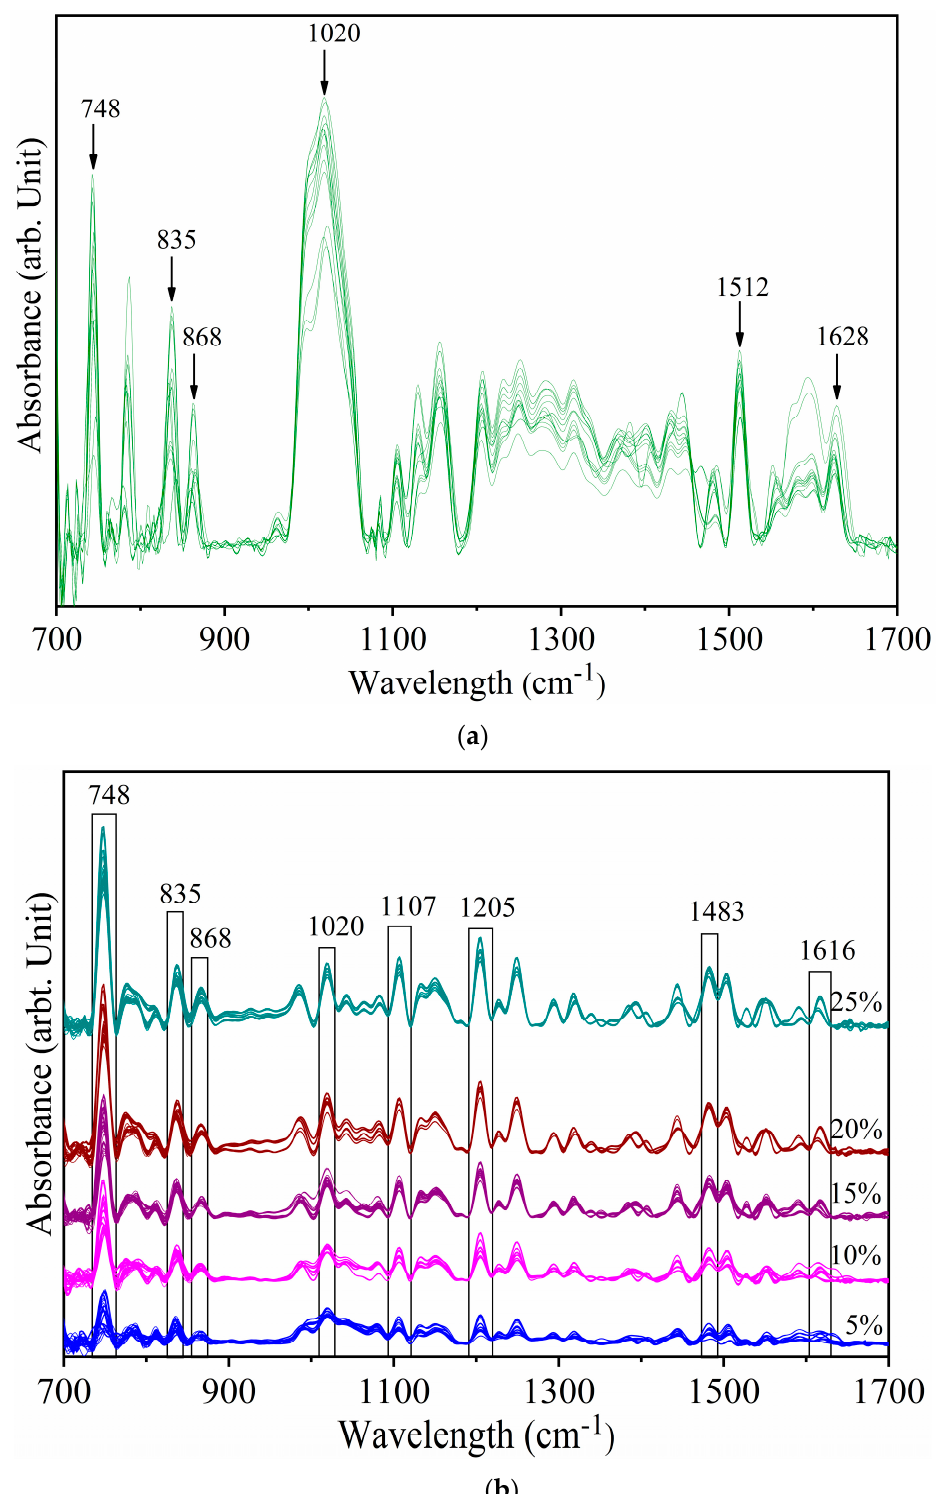
Figure 2. Spectra of yellow turmeric—Sudan Red sample ( a ) at 1% concentration ( b ) at 5%, 10%, 15%, 20%, and 25%